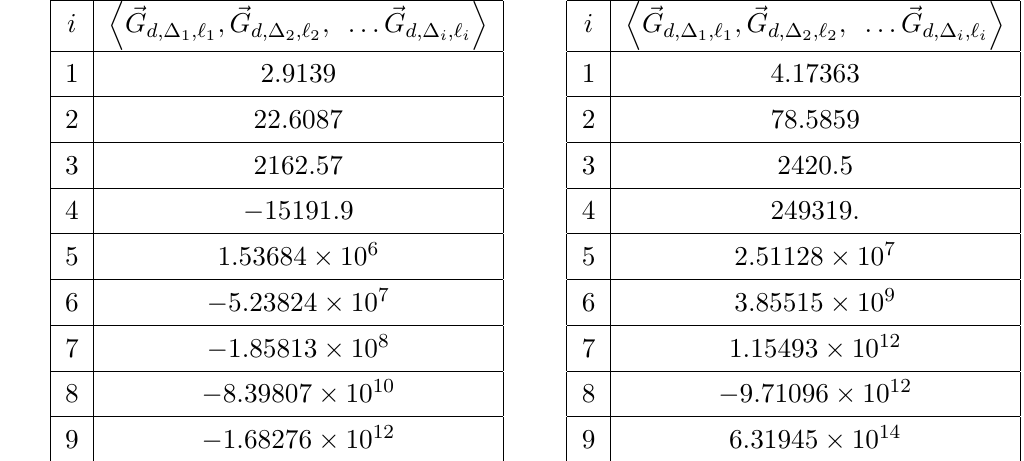
Table 5. Left: determinants of (cid:12)rst few operators of 2D Ising model using equation (2.1), spec- trum (B.1) and Right: determinants of (cid:12)rst few operators of 3D Ising model using (2.1), spec- trum